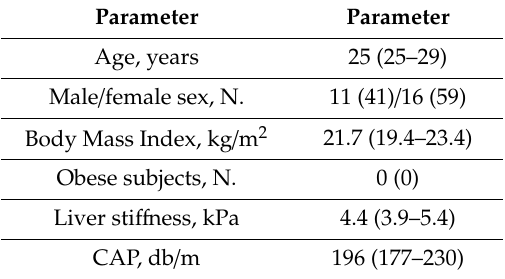
Table 3. Main demographic and clinical features of the healthy controls (N. = 27). Data are presented as medians (range) for continuous variables, and as frequencies (%) for categorical